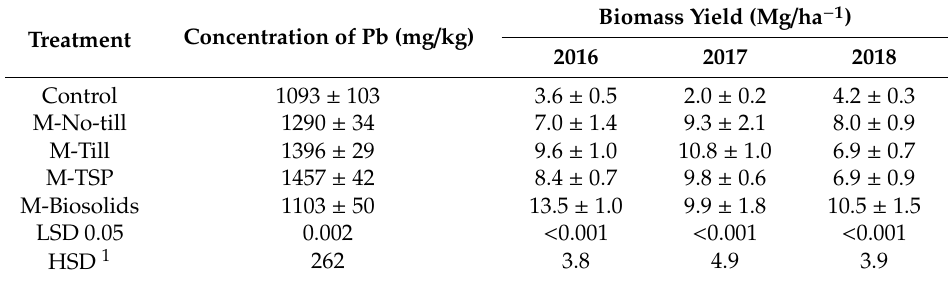
Table 2. Aged Pb concentration in the Ft.-Riley old skeet range soil and dry matter yield of Miscanthus for each growing season 2016, 2017, and 2018 (mean ± standard error mean for N =